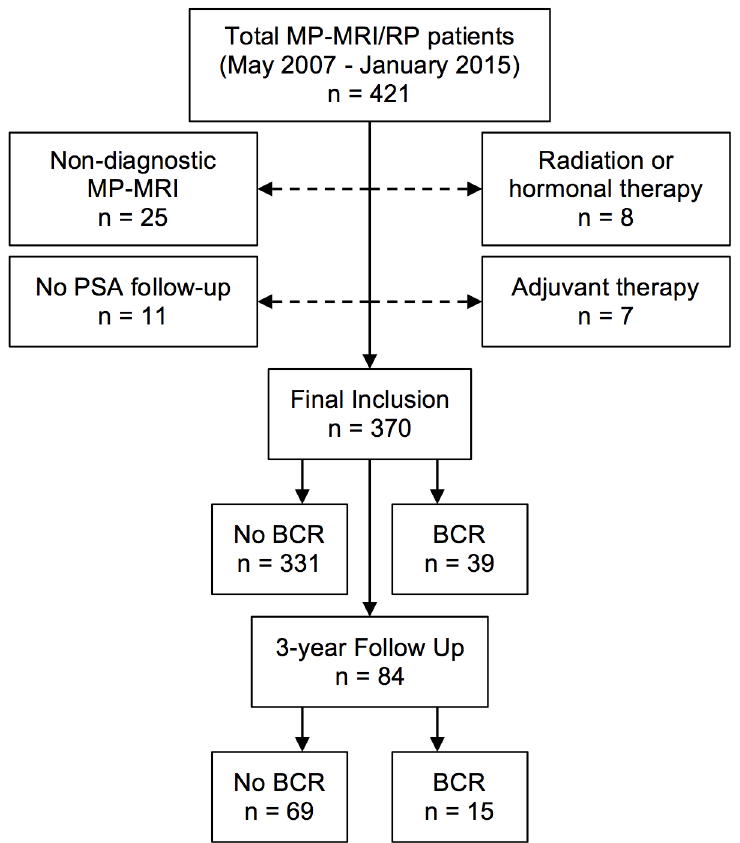
Fig 1. Flowchart of patient selection. MP-MRI = multiparametric magnetic resonance imaging; PSA = prostate-specific antigen; RP = radical prostatectomy.